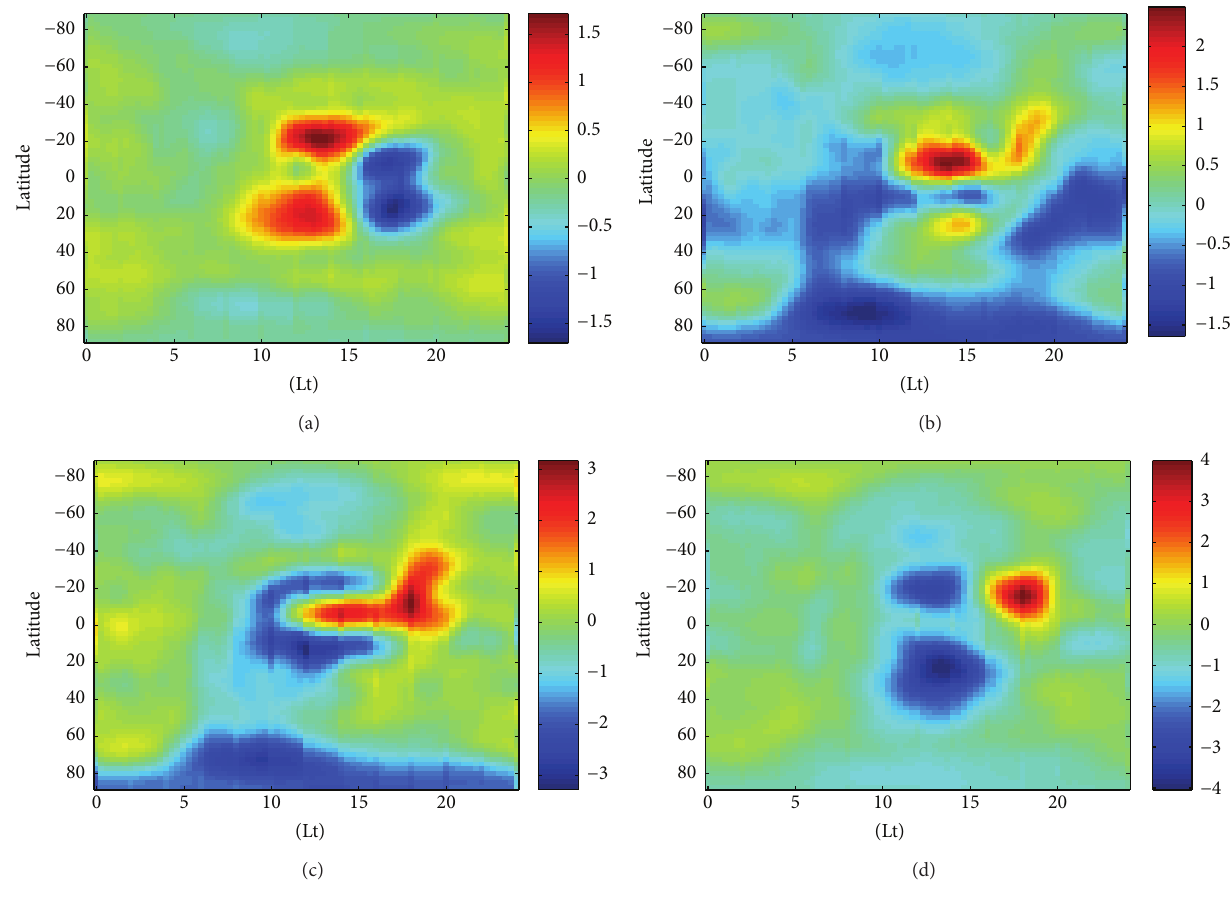
Figure 4: Error distributions by linear